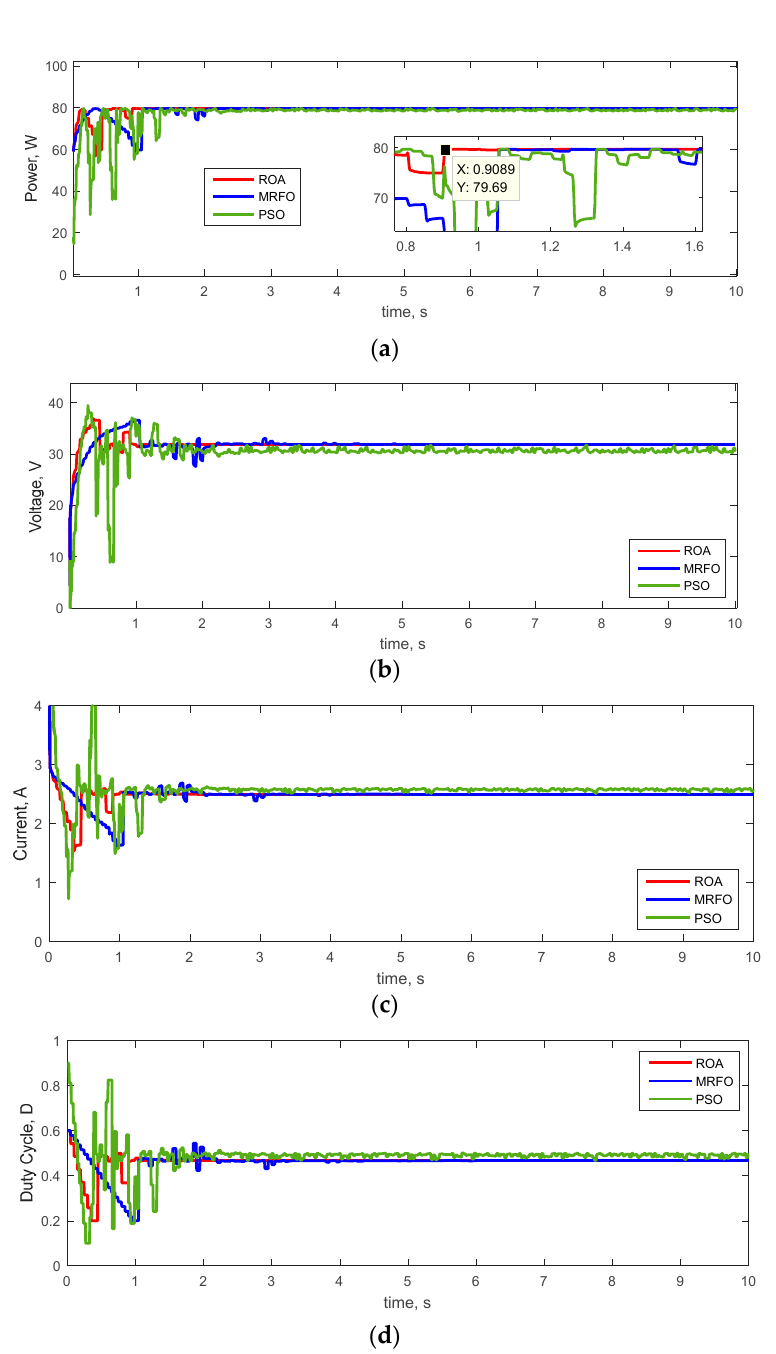
Figure 11. ( a ) PV power, ( b ) PV voltage, ( c ) PV current, ( d ) Duty cycle in pattern 3 using different methods.